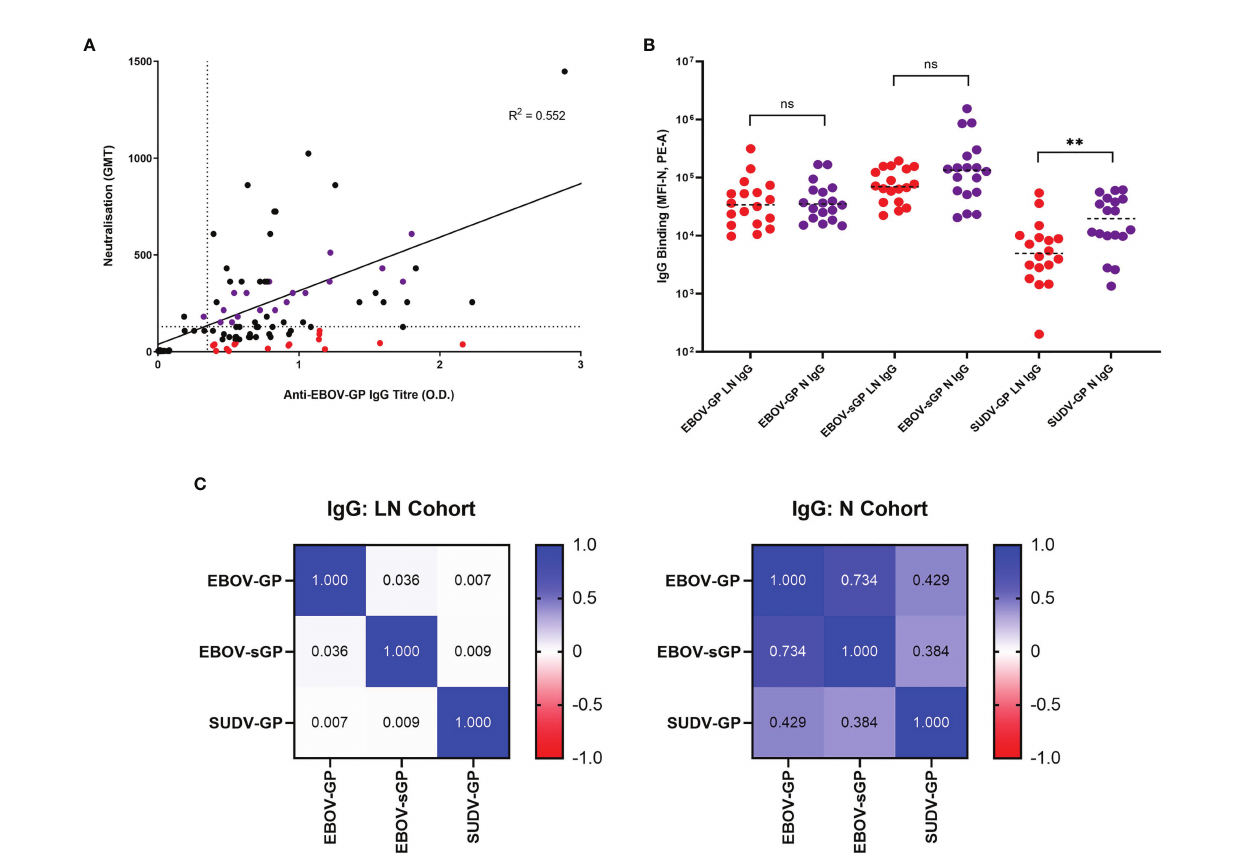
FIGURE 2 | Selection of EBOV-GP plasma samples and their abilities to bind EBOV-GP, EBOV-sGP, and SUDV-GP. (A) 145 samples from historic EBOV-GP ELISAs and EBOV neutralisation assays were correlated and analysed via linear regression. Samples greater than the axis limits were excluded from the graph for the purpose of clarity, but still included in the analysis. The LN cohort (red dots, n = 16) was selected using a neutralisation cut-off < 130 GMT (horizontal dotted line) and an antibody titre > 0.35 O.D. (vertical dotted line), with a maximum residual from the line of best fi t (< -100 GMT). The N cohort (purple dots, n = 16) was selected using a neutralisation cut-off > 200 GMT and the closest possible residual to the line of best fi t. (B) EBOV-GP, EBOV-sGP, and SUDV-GP conjugated beads were incubated with plasma from the LN (n = 18) or N (n = 18) cohorts and analysed via fl ow cytometry. Mean values are represented by horizontal dotted lines and signi fi cance determined using a Mann-Whitney U test. (C) A pairwise linear regression analysis was performed for each bead conjugate with LN (n = 18) and N (n = 18) plasma cohorts and the R 2 values for IgG binding were presented in the form of a heatmap. ** = signi fi cant (P < 0.01), ns, Not signi fi